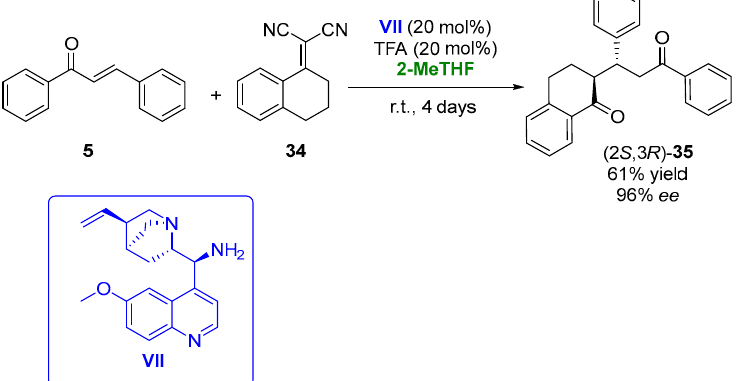
Figure 19. Addition of α , α -dicyanoolefins to chalcones catalyzed by cinchona-based catalysts in 2- MeTHF.